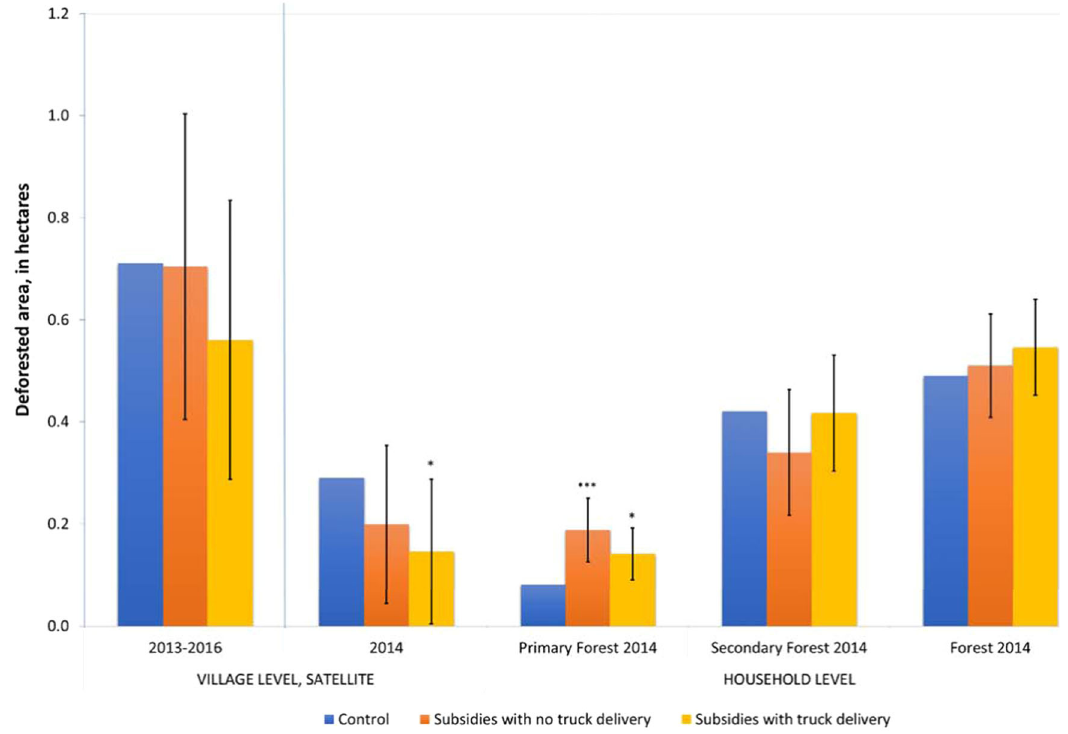
Fig. 3 | Deforestation measured with village and household survey data. Source: Hansen et al. 37 and Follow up survey waves 2014. Village-level estimates basedon n =92 independent villagesincluded in the experiment;Household-level estimates based on n =904 households living in the n =92 independent villages included in the experiment. Note: Results of village and household level regres- sions. Dependent variable: deforested area per household, in hectares. For all outcomes, the inverse hyperbolic sine transformation is used (see Supplementary Information,SectionA.1).Eachbarrepresentstheordinaryleastsquare(OLS)point estimates, and vertical lines show a 90% con fi dence interval for the difference between treatment and control groups, with standard errors clustered at the vil- lage level. Treatment values that are signi fi cantly different from the control are indicated with stars. See detailed regression results in Table A.1. Village-level regressions (on the left) use the average of two estimates of village-level defor- estation divided by the number ofhouseholds in the village, the fi rst based on the